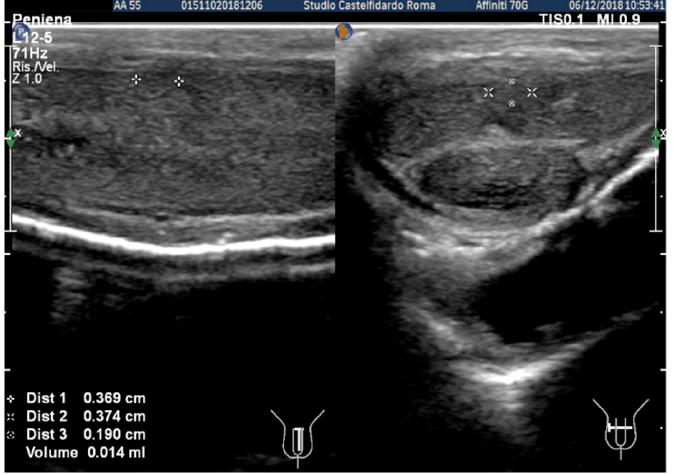
Figure 9. Ultrasonography of the penis after the third treatment cycle (longitudinal and transverse views).